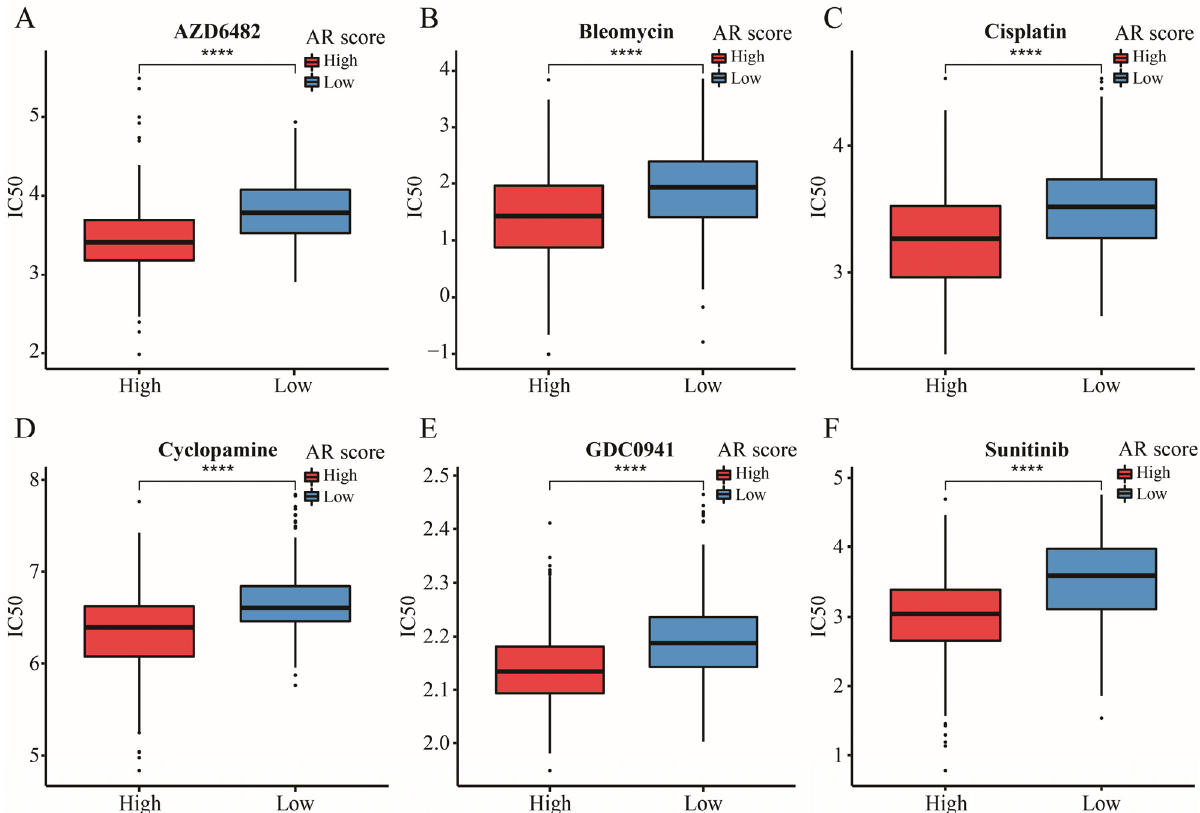
Figure 12. The IC50 of six classic chemotherapeutic drugs between high- and low-AR groups. Data in ( A – F ) were analyzed by Wilcoxon test; **** p < 0.0001 .